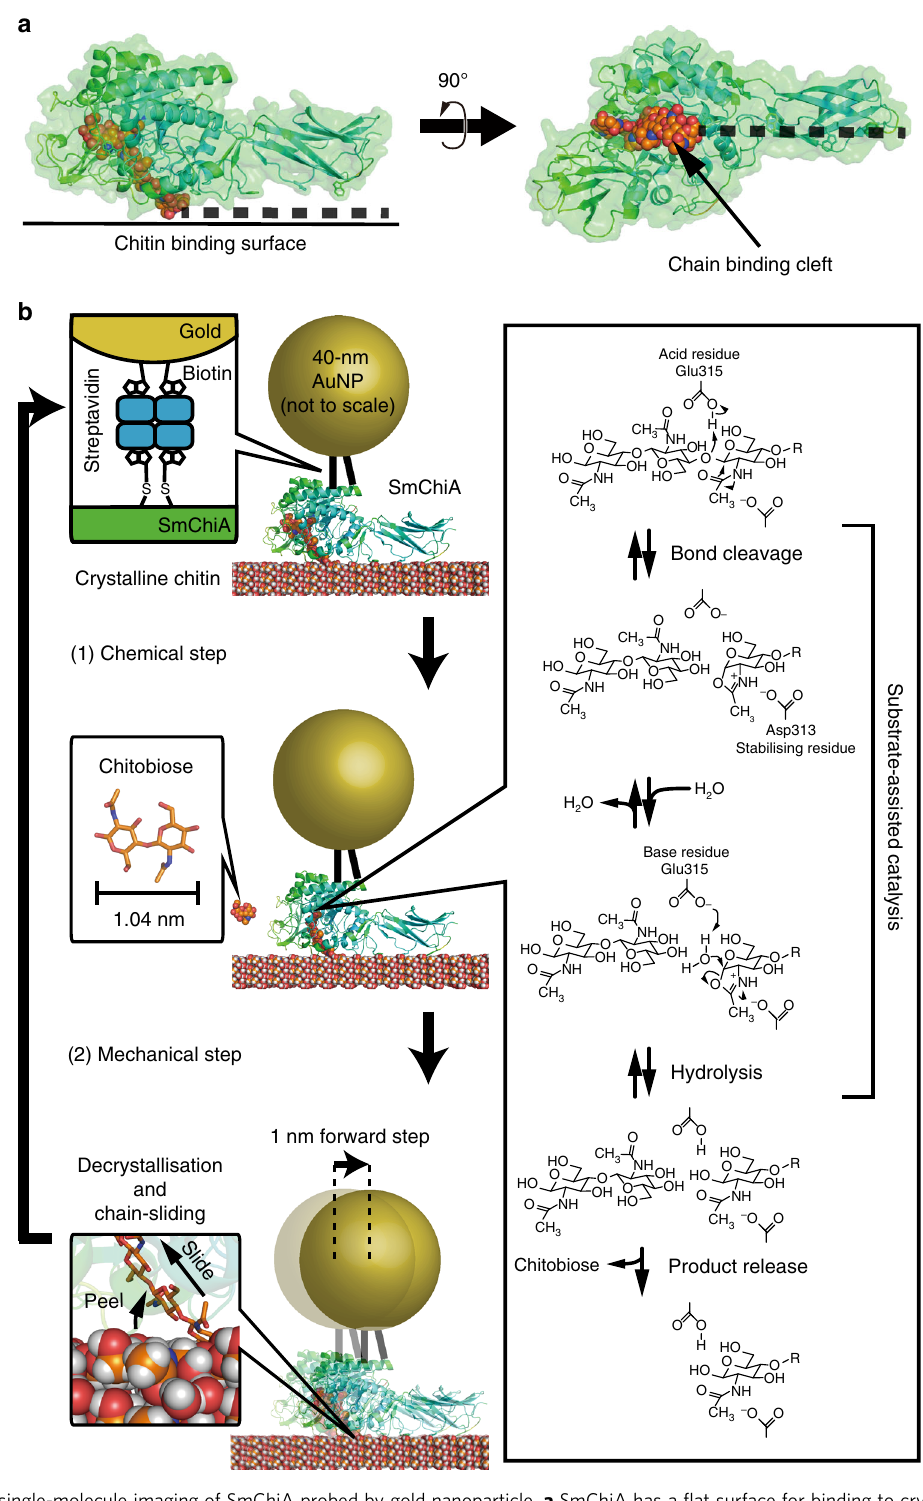
Fig. 1 Schematic of single-molecule imaging of SmChiA probed by gold nanoparticle. a SmChiA has a fl at surface for binding to crystalline chitin and the cleft for threading decrystallized single chain of chitin. b A single AuNP was attached to SmChiA via streptavidin-biotin interaction. Elementary steps were categorised as chemical (substrate-assisted catalysis and product release) or mechanical (decrystallization and chain sliding) step. Length of the reaction product chitobiose (1.04 nm) corresponds to expected step size of SmChiA